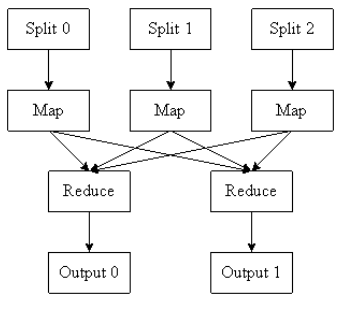
Figure 3: MapReduce calculation model